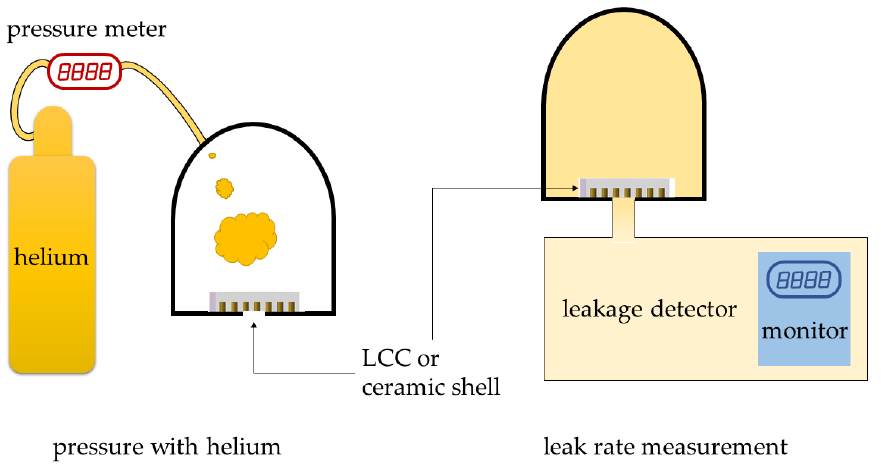
Figure 6. The schematic diagram shows the hermeticity measurement of LCC and ceramic shell.